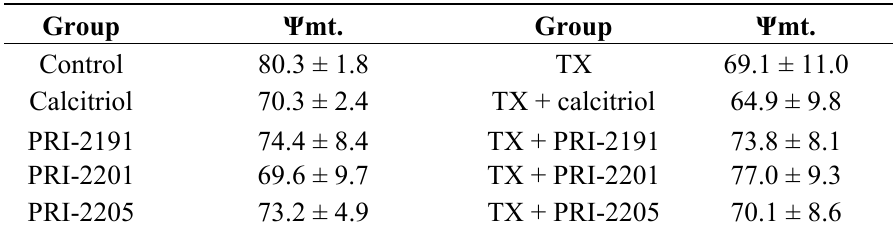
Table 7. Mitochondrial membrane potential ( Ψ mt.) of MCF-7 cells treated with TX alone or combined with vitamin D analogs.